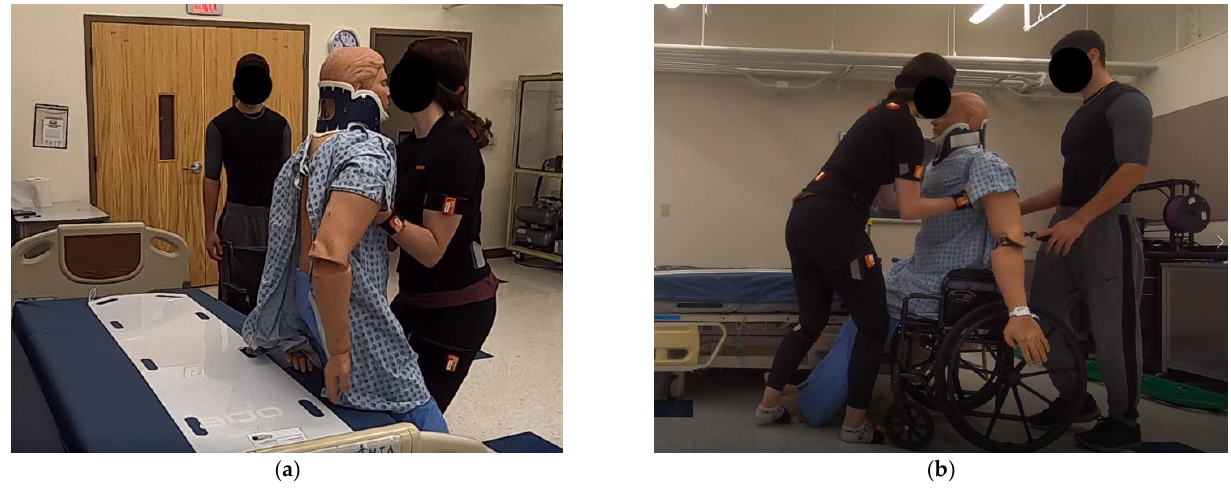
Figure 2. Task#2: Transferring the patient manikin from a bed to a wheelchair. ( a ) Moving the man- ikin from the hospital bed. ( b ) Placing the manikin into the wheelchair. manikin from the hospital bed. ( b ) Placing the manikin into the